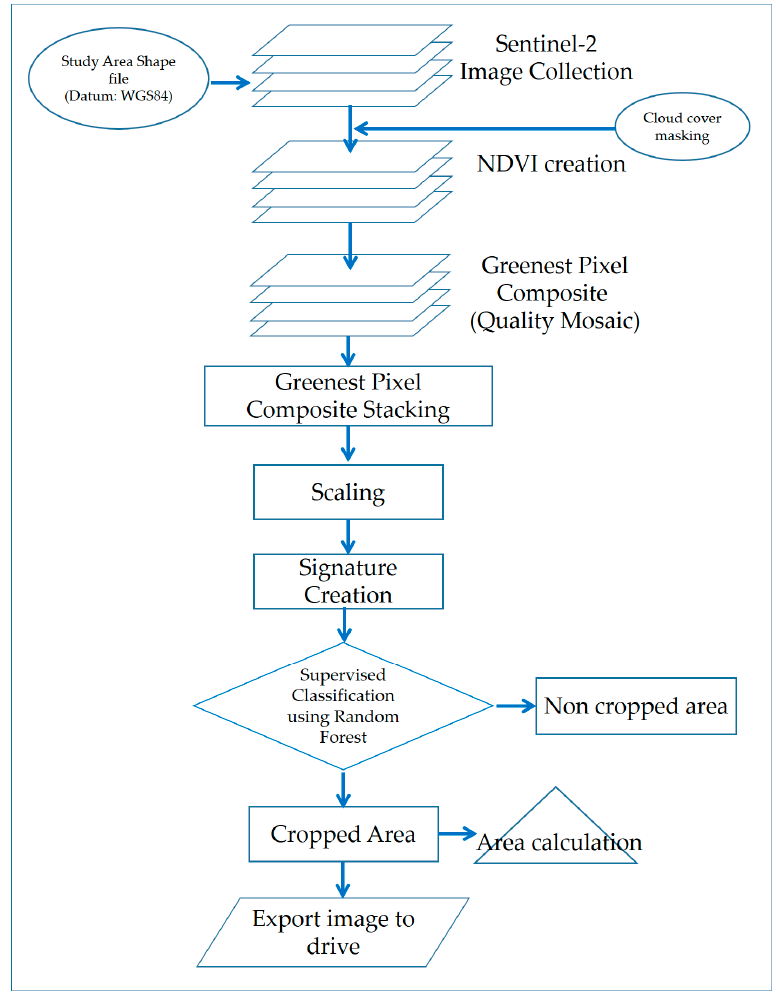
Figure 3 . Algorithm execution . Figure 3. Algorithm execution. Table 1. Band information of the Sentinel-2 satellite images